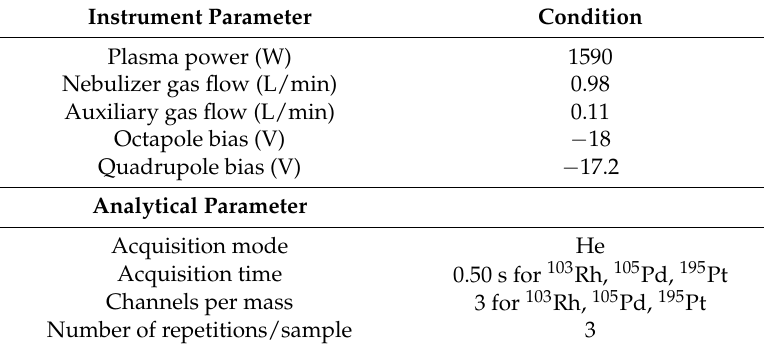
Table 2. ICP-QMS operating conditions